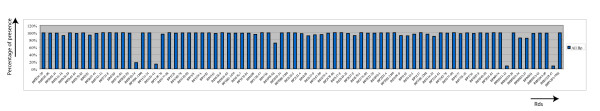
The frequency at which regions of difference (RD) are present in B. pertussis clinical strains isolated in 6 different countries between 1949 and 2008. Histogram of the average gene content of all 171 B. pertussis strains analyzed. Bars indicate the presence percentage of the gene or geneclusters (RDs).